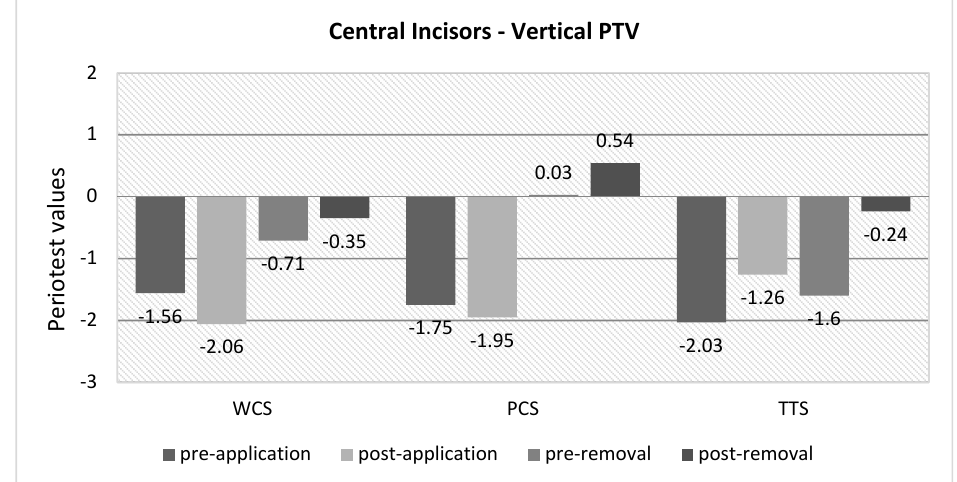
Figure 4. Horizontal Periotest values for central incisors.